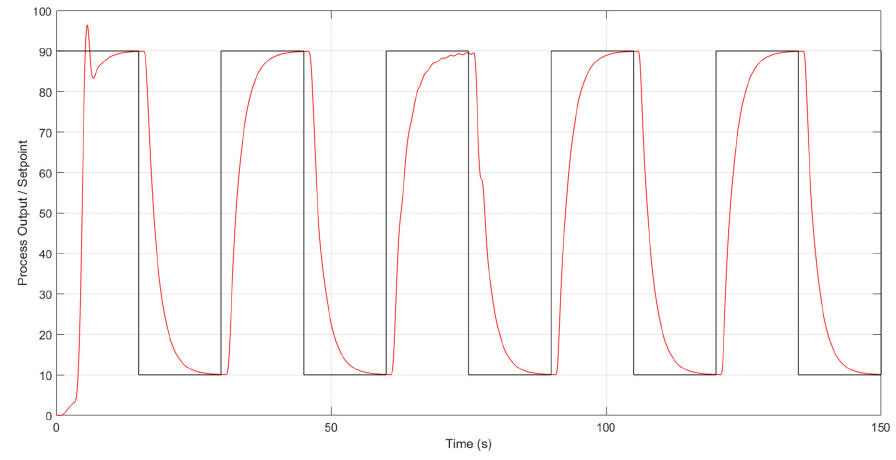
Figure 9. Tracking performance of the controller in the constrained case. Red: process output; black: setpoint.